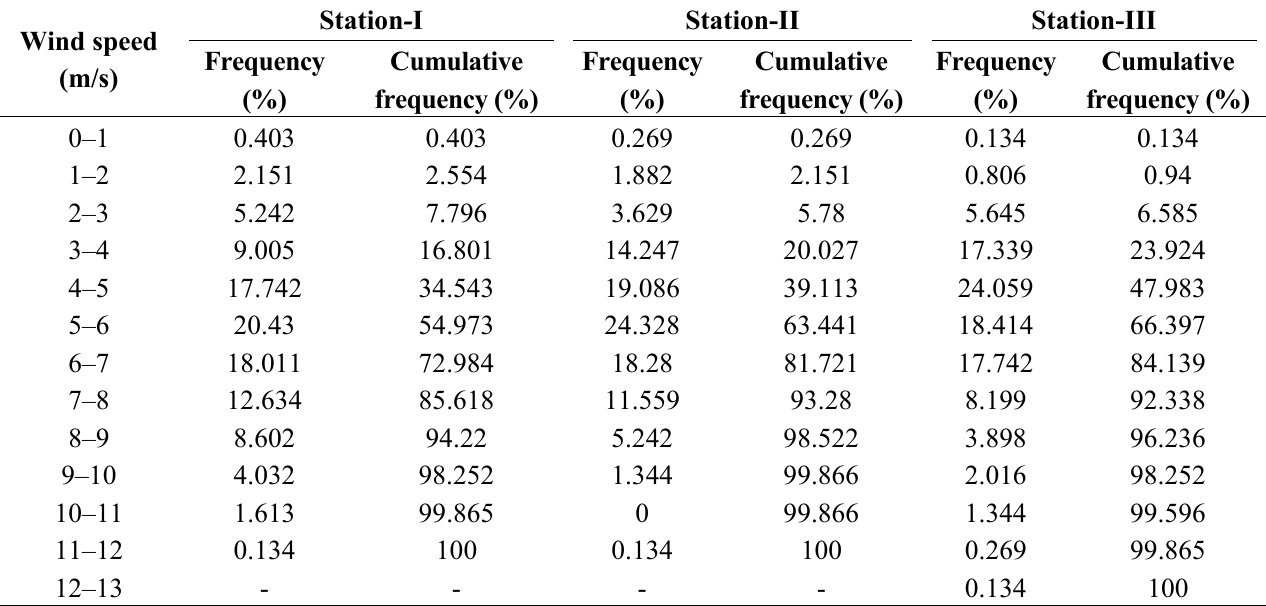
Table 3. Frequency distribution and cumulative frequency distribution for the selected sites in June.